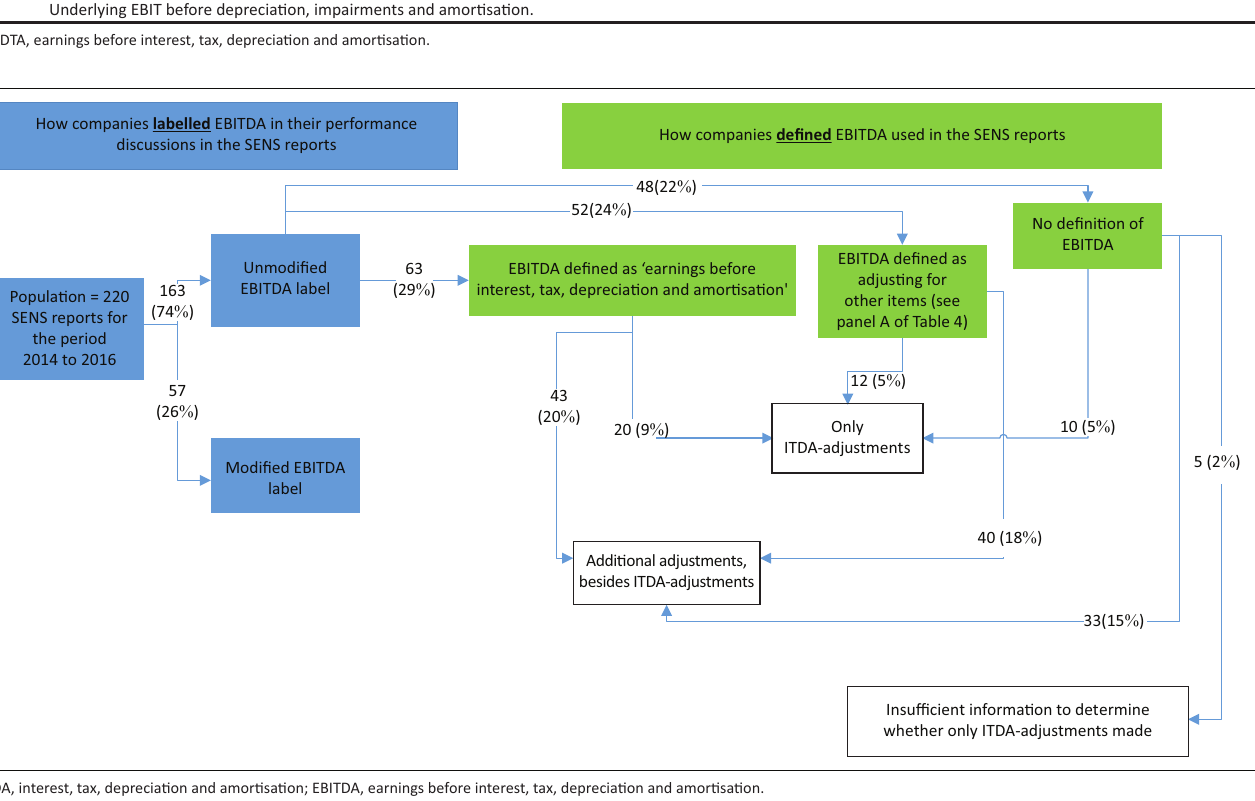
FIGURE 5: Discrepancies between how Stock Exchange News Service reports labelled, defined and calculated earnings before interest, tax, depreciation and amortisation for the period 2014–2016 ( N = 220).